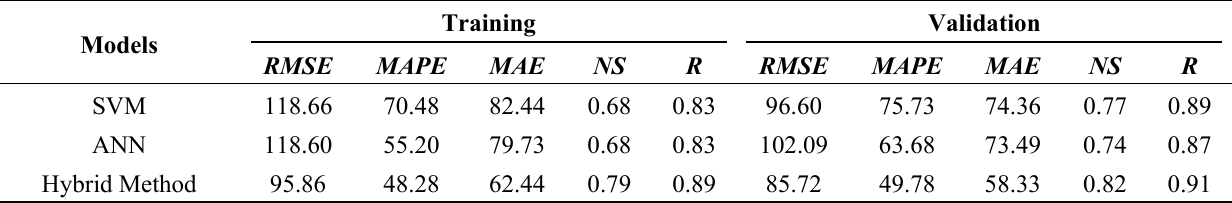
Table 3. Model statistics of three models for Xinfengjiang reservoir.